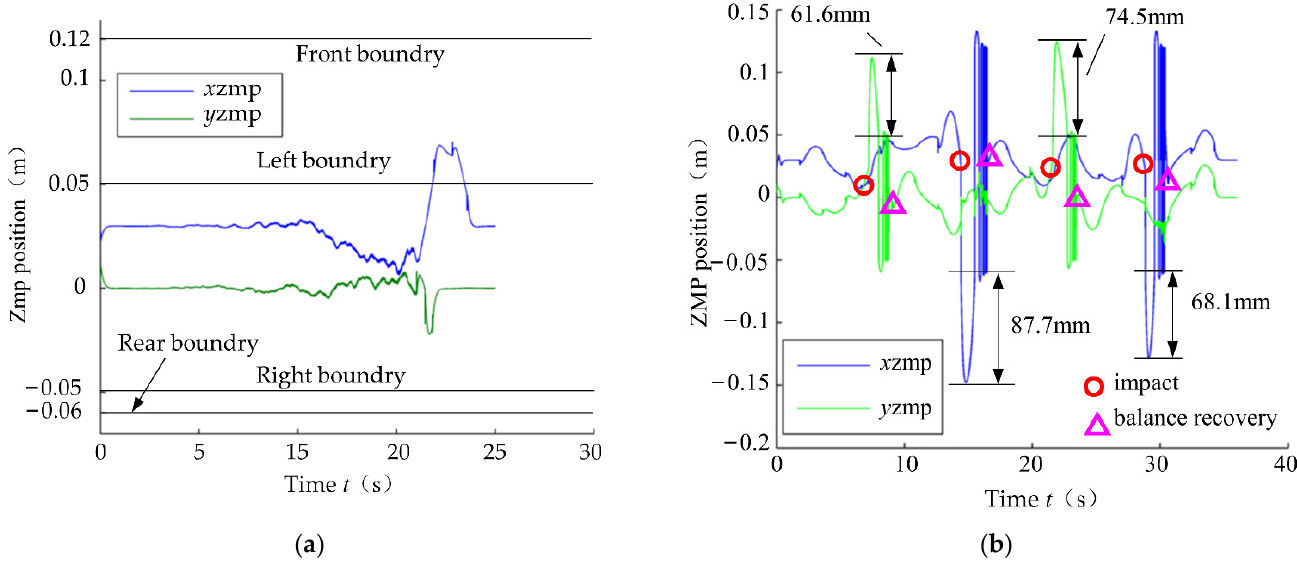
Figure 11. ZMP curves in two single-leg stance simulations. ( a ) Without impact; ( b ) with impact.